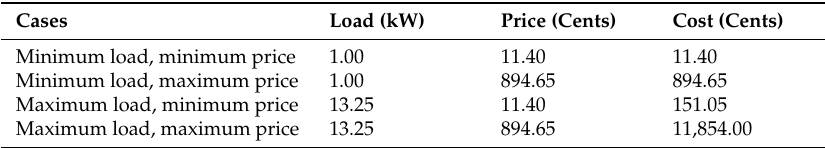
Table 6. Showing the possible formulated cases for CPP.